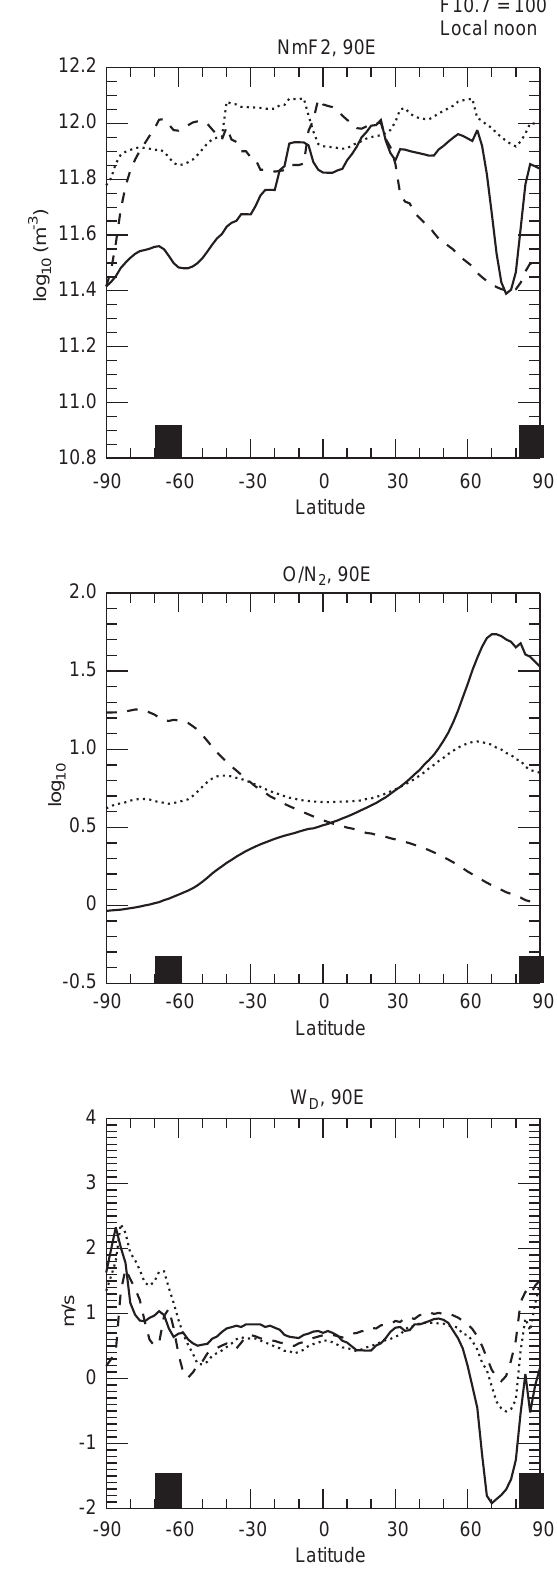
Fig. 3. Noon W D , N mF2 and (cid:137) O = N 2 (cid:138) ratio versus geographic latitude at longitudes 90 (cid:14) E and 90 (cid:14) W, for December ( solid curves ), March ( dotted curves ) and June ( dashed curves ). Black blocks show the northern and southern auroral ovals. The northern oval at